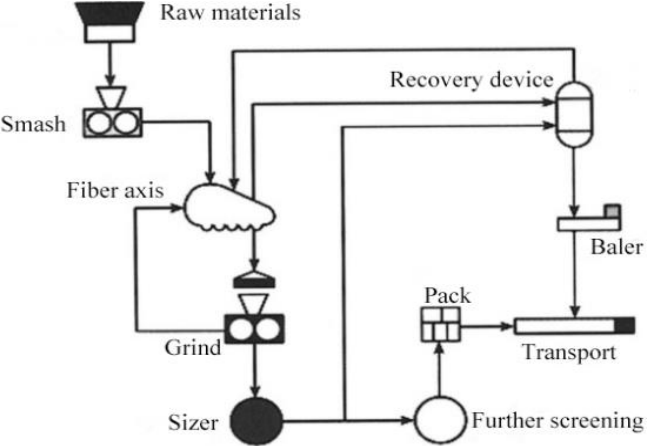
Figure 3. The grinding process at normal temperature.